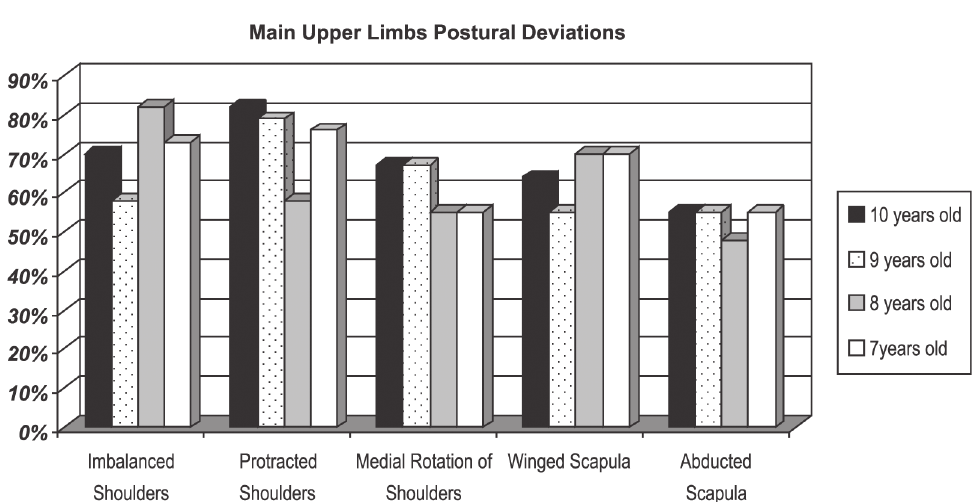
Figure 3 - Comparison among the main postural deviations of the upper